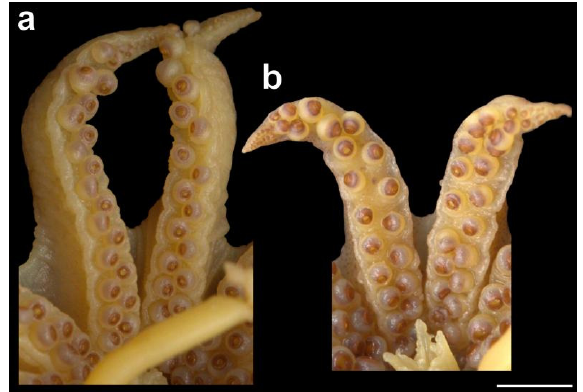
Figure 15. Sepia typica variation in arms I p. in males: ( a ) SAIAB 211540, ML 22 mm with differentiated arm suckers; ( b ) SAIAB 211557, ML 20 mm with undifferentiated arm suckers. Scale bar 2 mm.